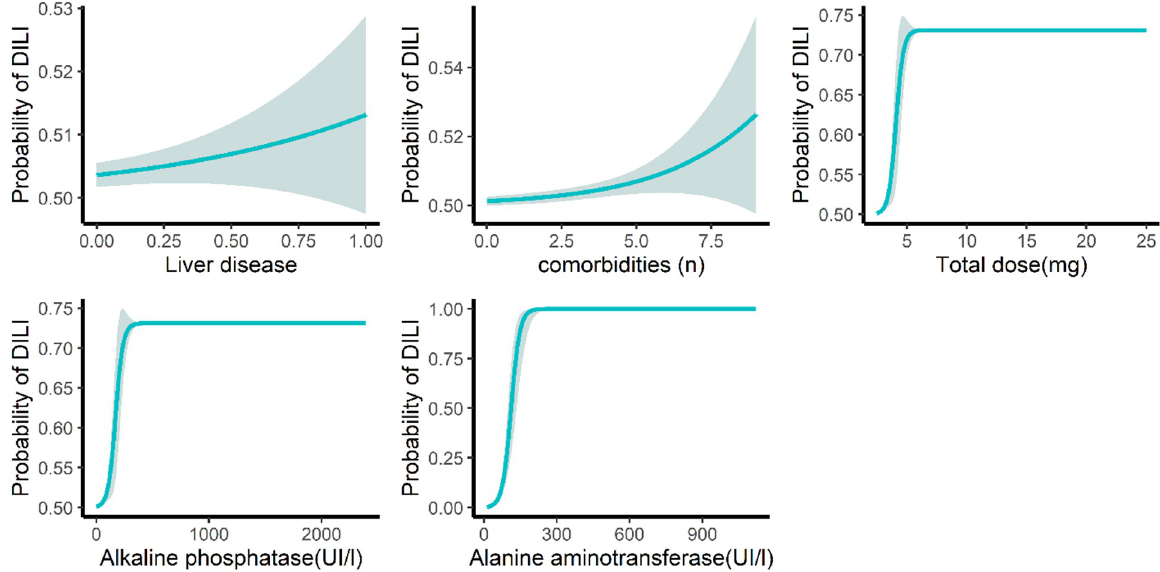
Fig 3. Impact of independent predictors on the probability of drug induced liver injury on multiple logistic-regressions. DILI: drug induced liver injury.